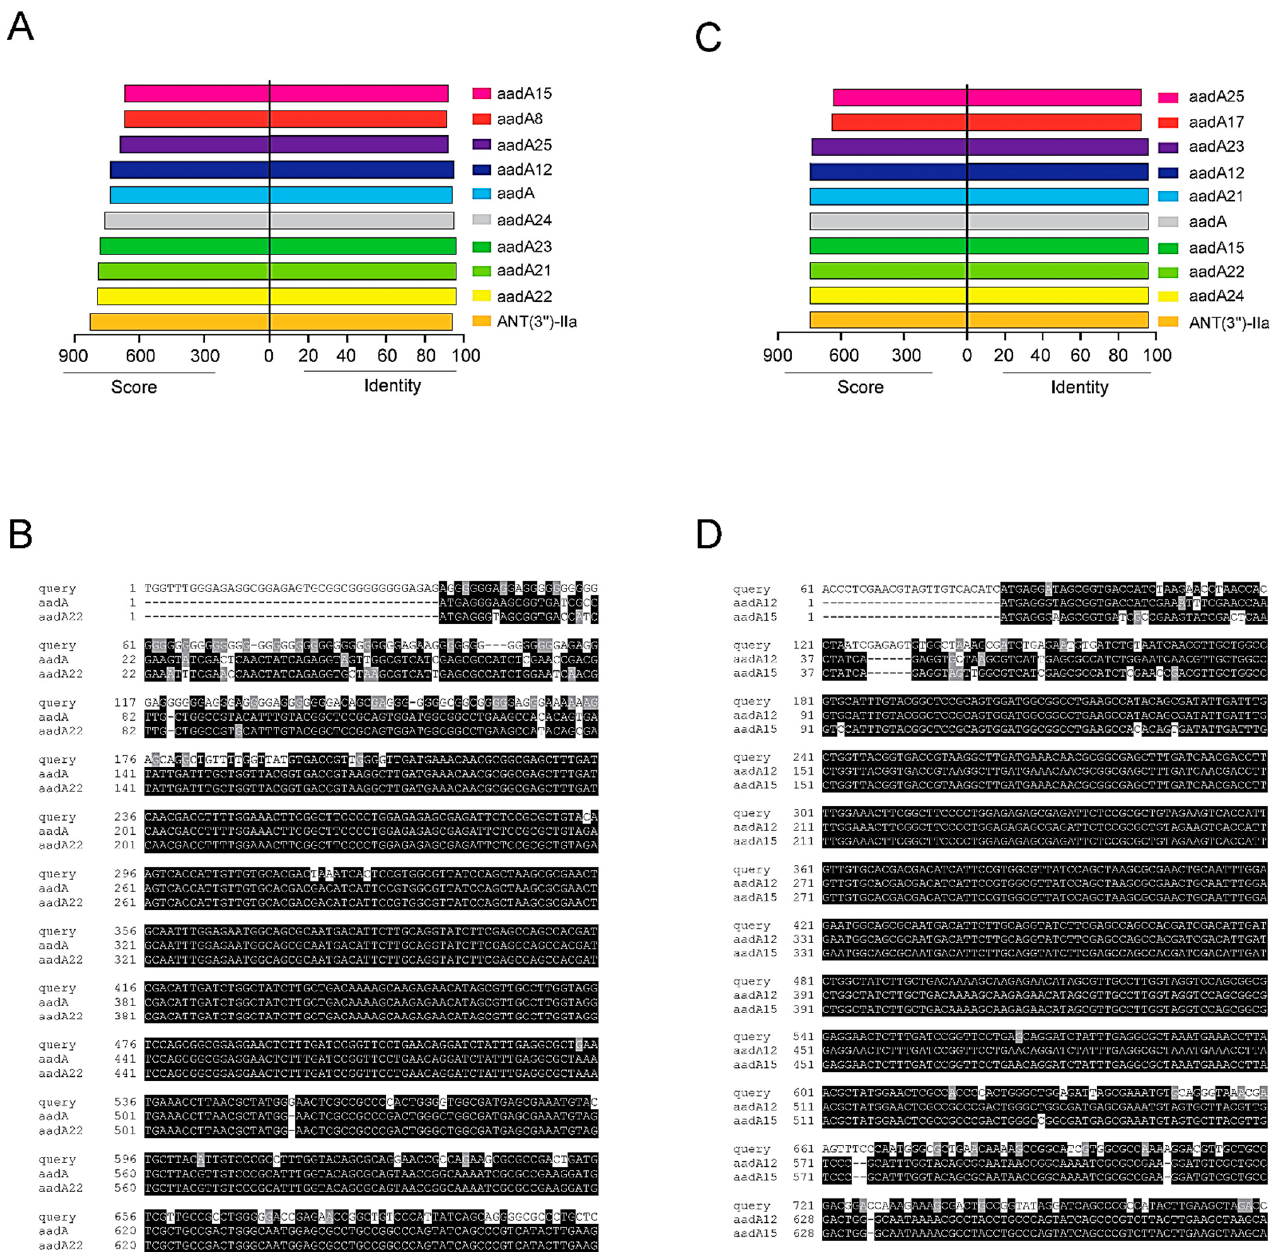
Figure 4. ( A ) Bar blots indicating the identity percentage and covered score of the sequenced query 1 against the most likelihood AMR genes recognized by the Comprehensive Antibiotic Resistance Database (CARD). ( B ) Multiple sequence alignment of one category of the identified AMR genes (query 1) with the sequences of aadA and aadA22 genes retrieved from banked microbial resistome that give a high identity to the queried sequence analyzed via CARD; the available sequences are aligned via ClustalW and BOXSHADE and were employed to highlight the multiple alignment. Black shading indicates that the residue is identical to the column consensus; gray shading indicates that the residue is not identical but at least similar to the column consensus; and no shading indicates that the residue is neither identical nor similar to the consensus [24]. ( C ) Bar blots indicating the identity percentage and covered score of the sequenced query 2 against the most likelihood AMR genes retrieved from CARD. ( D ) CLUSTAL W multiple sequence alignment of the other category of the identified AMR genes (query 2) with the sequences of aadA12 and aadA15 genes retrieved from banked microbial resistomes that give a high identity to the queried sequence using CARD; the available sequences are aligned and shaded via ClustalW and BOXSHADE, as previously described.